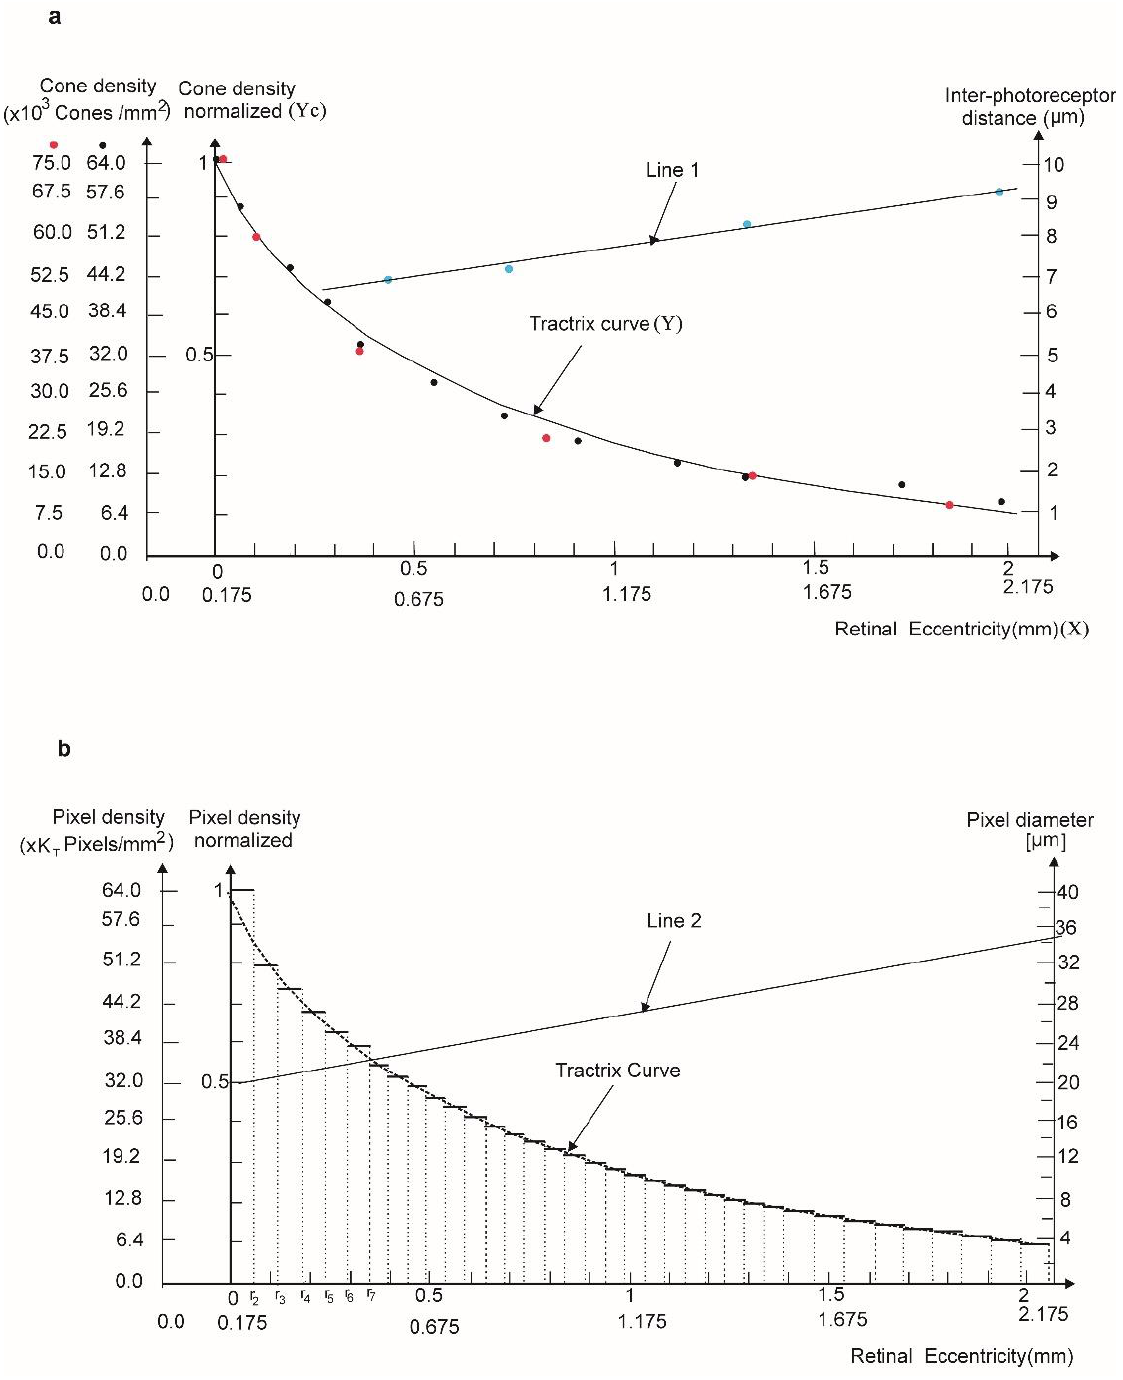
Figure 2. The shape and characteristics of cone density surface in macula. ( a ) Normalized cone density (black points are data from [20] and red points are data from [21] and the tractrix fitting curve. Line 1 is the interpolation of the inter-photoreceptor cell distances as a function of eccentricities data set in [20]. ( b ) The pixels’ eccentricity distribution on the artificial human macula (AHM) in elliptical shape achieved by an arrangement of photoreceptors of 20 µ m. Line 2, parallel to line 1, shows the linear pixel diameter increase with increasing eccentricity.